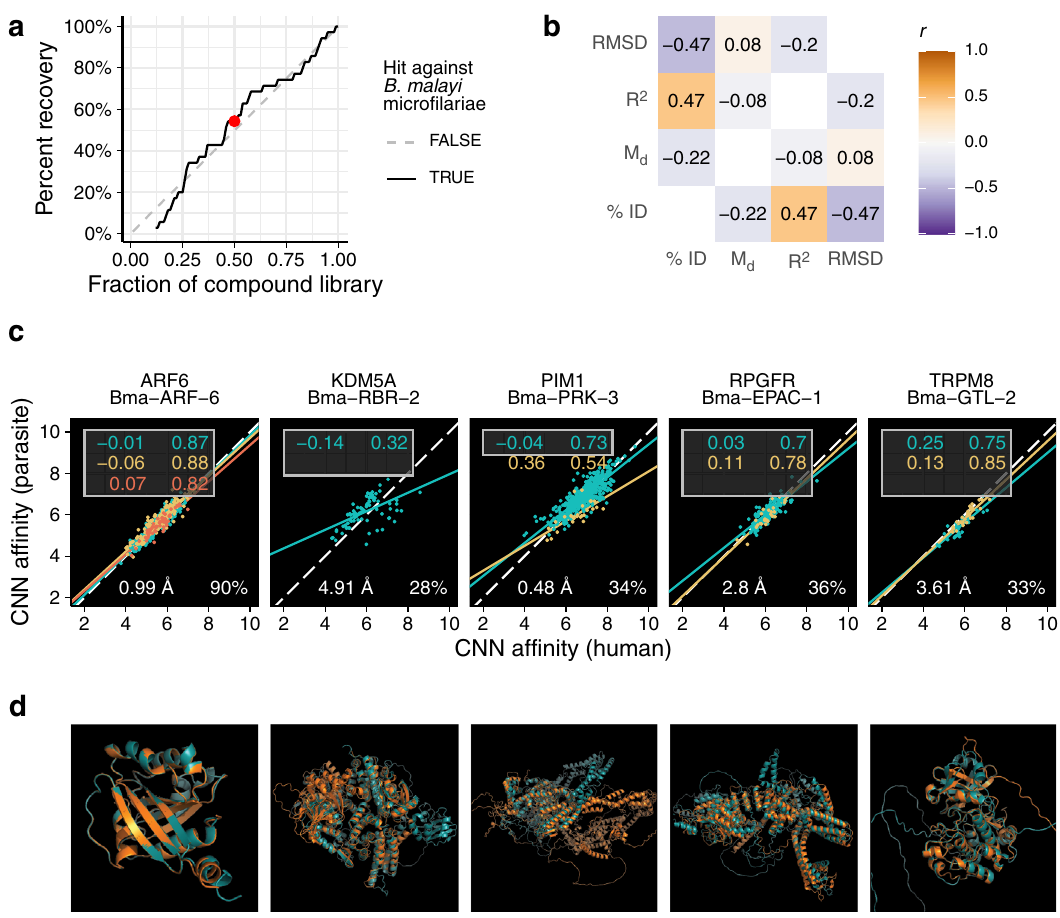
Fig. 3 A virtual screening strategy using AlphaFold2 models of B. malayi and human targets. a Performance of a virtual screening strategy as a fi lter prior to an in vitro primary screen. When compounds are ranked by docking score, using only the highest ranked compounds at different cutoffs would have slightly enriched for hits against micro fi laria (e.g., screening the highest ranked 50% of the library would have resulted in retrieval of 60% of the hits — red point). b A docking-based binding site comparison between orthologous host and parasite targets provides unique information that is non-redundant with other types of comparisons. c Clockwise starting at the top-left: mean distance from y = x ( M d ), R 2 of linear fi ts, primary sequence percent identity, and root-mean-square deviation of atomic position of aligned AlphaFold2 structures. Lines, points, and labels are colored by binding site (only the top 3 consensus sites were retained, site #1 = cyan, site #2 = yellow, site #3 = red). Each point represents the af fi nity scores for the same compound docked to orthologous structures. d Aligned AlphaFold2 orthologous structures from B. malayi (cyan) and humans